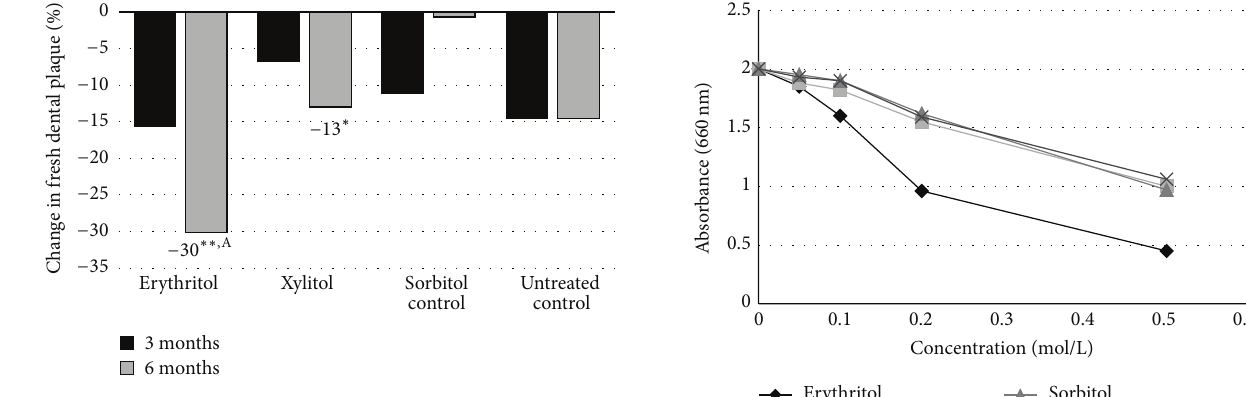
Figure 1: Percent change in fresh dental plaque weight against baseline over a 6-month period in a teenage cohort consum- ing erythritol-, sorbitol-, or xylitol-containing chewable tablets. Adapted from M¨akinen et al. [10] and M¨akinen (personal commu- nication). ∗ 𝑝 < 0.05 when compared to baseline using a paired 𝑡 - test. ∗∗ 𝑝 < 0.001 when compared to baseline using a paired 𝑡 -test. A 𝑝 < 0.05 changes from baseline when compared with untreated control, sorbitol, or xylitol.